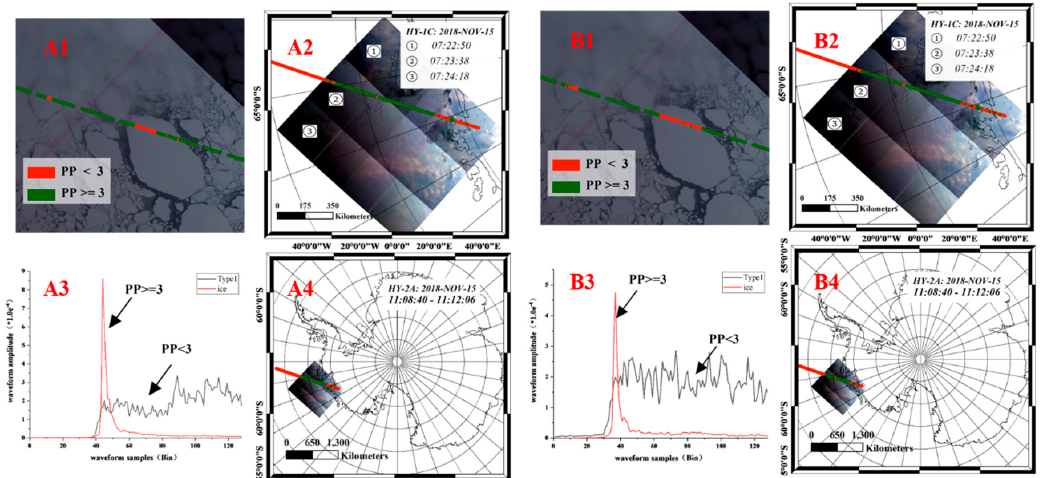
Figure 10. Distributions of classified PP values of the HY-2A ALT data. Note: A1 — A4 indicate the Ku Band; B1 — B4 indicate the C Band.